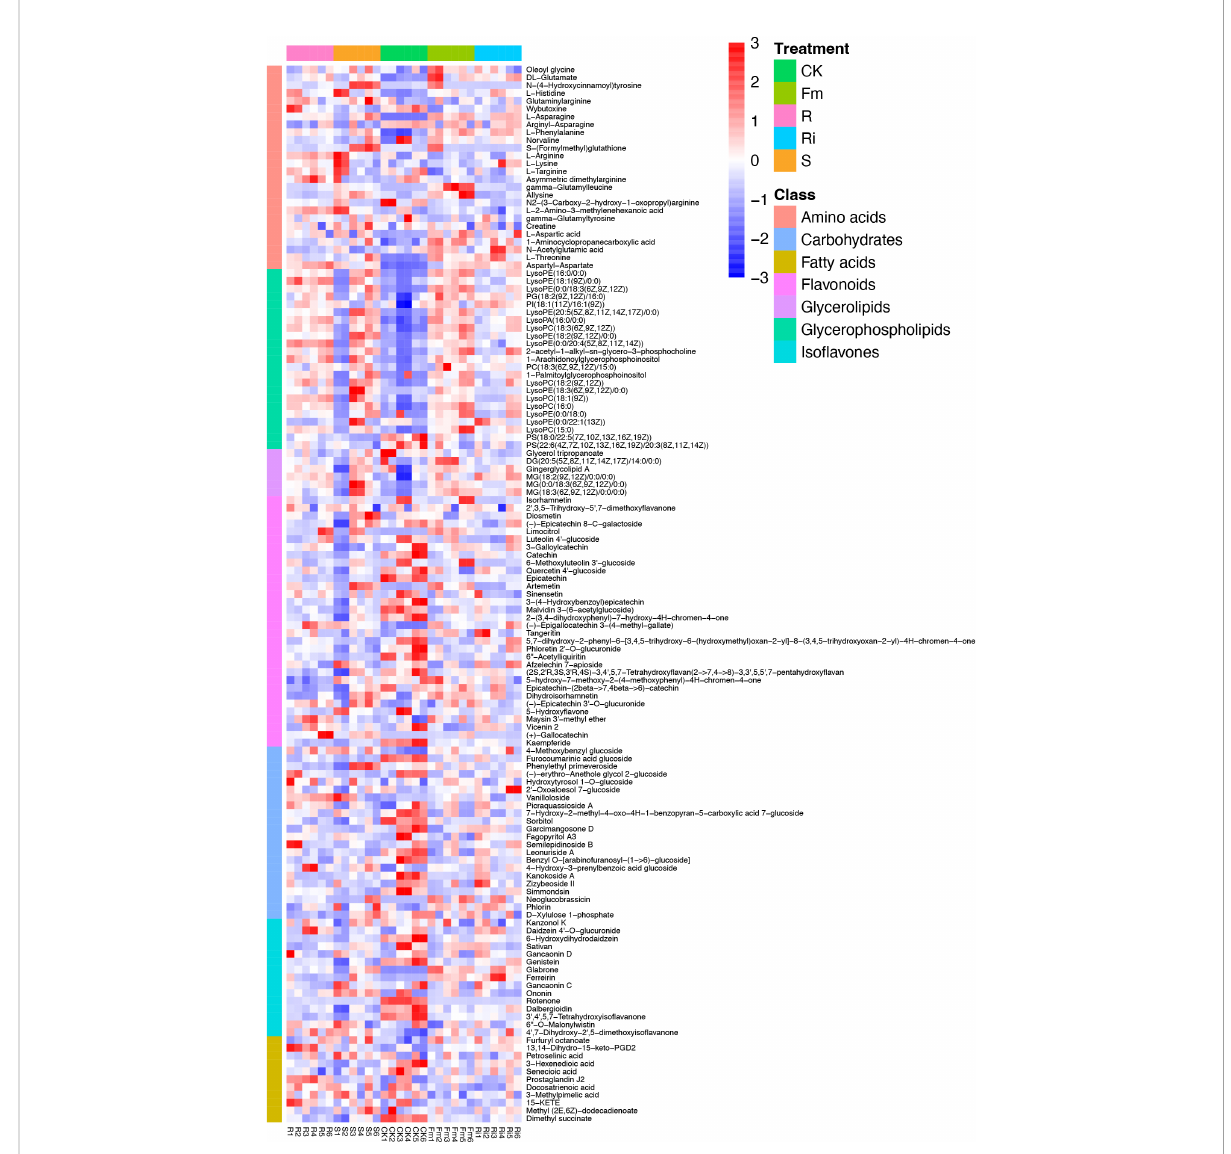
FIGURE 3 Heatmap of metabolites in Pyrus betulaefolia root. CK, sterilized soil from CK in Trifolium repens mixed with sterilized standard soil; R, soil from R in Trifolium repens mixed with sterilized standard soil; S, soil from S in Trifolium repens mixed with sterilized standard soil; Fm, Funneliformis mosseae inoculum mixed with sterilized standard soil; Ri, Rhizophagus intraradices inoculum mixed with sterilized standard